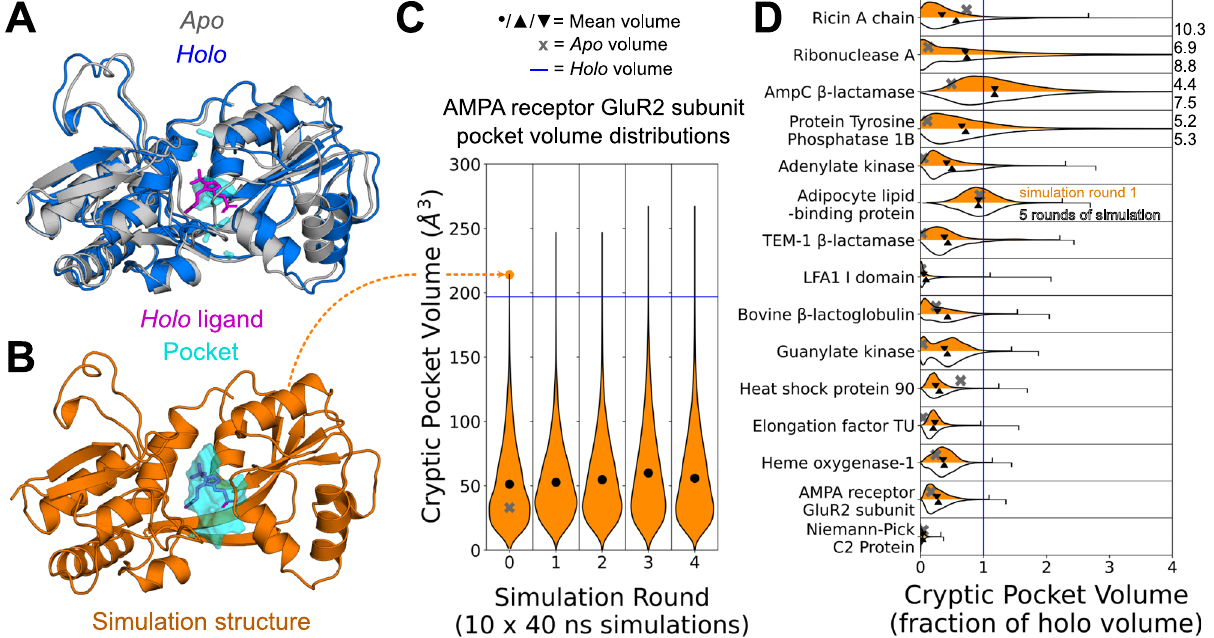
Fig. 2 | Cryptic pockets rapidly open in simulations started from closed apo structures.A StructuraloverlayoftheGluR2subunitoftheAMPAreceptorprotein in its apo (grey, PDB: 1MY0 72 ) and holo (blue, PDB: 1N0T 73 ) conformations reveals thataloop and helixmustshift toformacrypticpocket. B AstructurefromanMD simulation started from the closed apo conformation with a pocket at the binding sitewithavolumeexceeding thatof the holo binding sitepocket(orange). C MSM- weighted violin plots ofcrypticpocketvolume in simulations of the GluR2 subunit oftheAMPAreceptorshowthattheligandbindingsiteexceedsthevolumeseenin the holo conformation within only 10 parallel simulations of 40ns each. Cryptic pocket volume was calculated by assigning each LIGSITE 30 grid point to the single nearest residue and summing up the volumes assigned to all cryptic pocket resi- dues (see Methods). The grey ‘ X ’ indicates the apo binding site cryptic pocket volume, the blue line indicates the holo volume, and the black dot indicates the